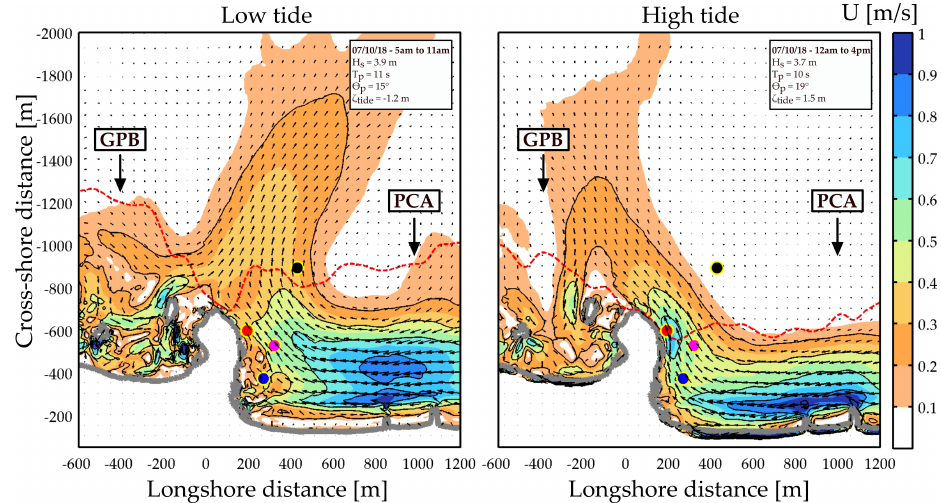
Figure 9. Modelled velocity field averaged at low tide ( left ) and high tide ( right ) of the high-energy deflection event. For each panel, the top-right white square shows the period of averaging, the corresponding offshore wave conditions ( H s , T p , θ p ) and tide level ( ζ tide ). The red line represents the outer edge of the surf zone computed as the cross-shore location where wave dissipation reaches 10% of its cross-shore maximum (similar to